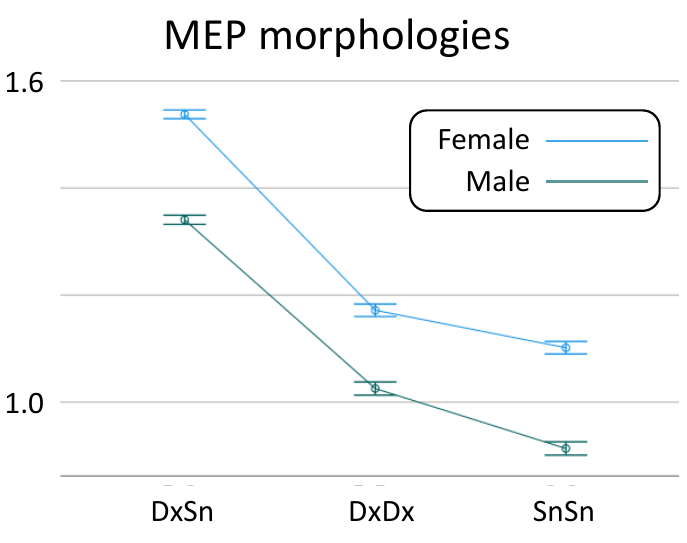
Figure 3. Sex-dependent MEP morphology similarity. The overall values and standard deviation of Fréchet distances between inter-side (DxSn) MEP morphologies, the intra-side distances in the right (DxDx) and left (SnSn) distinct for Sex.